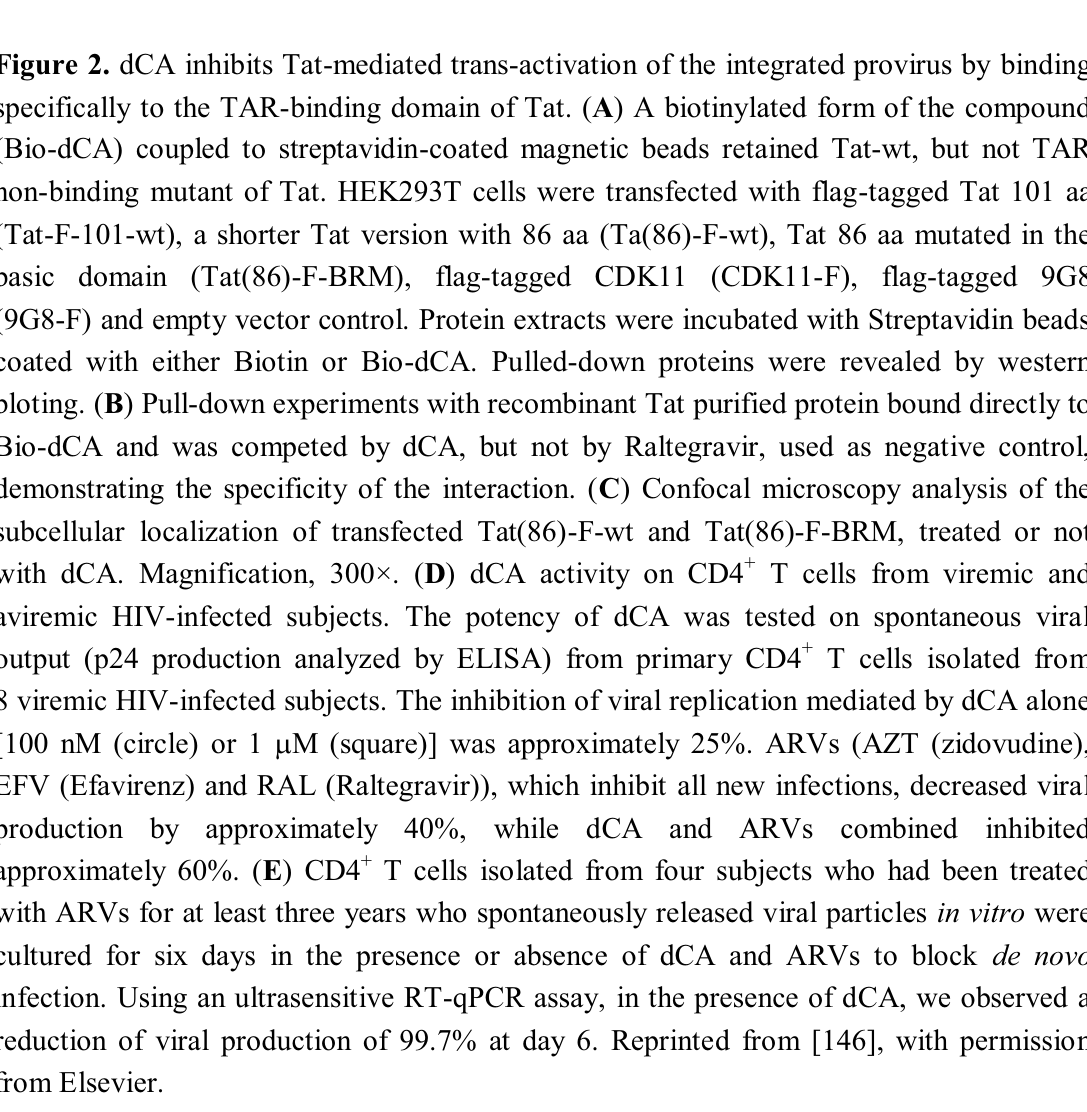
Figure 2. dCA inhibits Tat-mediated trans-activation of the integrated provirus by binding specifically to the TAR-binding domain of Tat. ( A ) A biotinylated form of the compound (Bio-dCA) coupled to streptavidin-coated magnetic beads retained Tat-wt, but not TAR non-binding mutant of Tat. HEK293T cells were transfected with flag-tagged Tat 101 aa (Tat-F-101-wt), a shorter Tat version with 86 aa (Ta(86)-F-wt), Tat 86 aa mutated in the basic domain (Tat(86)-F-BRM), flag-tagged CDK11 (CDK11-F), flag-tagged 9G8 (9G8-F) and empty vector control. Protein extracts were incubated with Streptavidin beads bloting. ( B ) Pull-down experiments with recombinant Tat purified protein bound directly